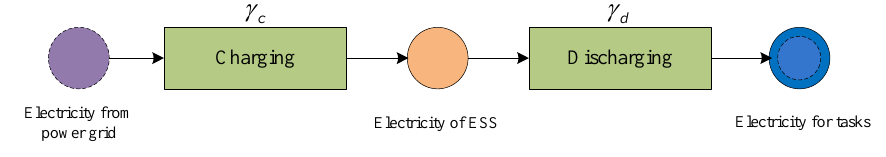
Figure 8. STN model of the ESS.